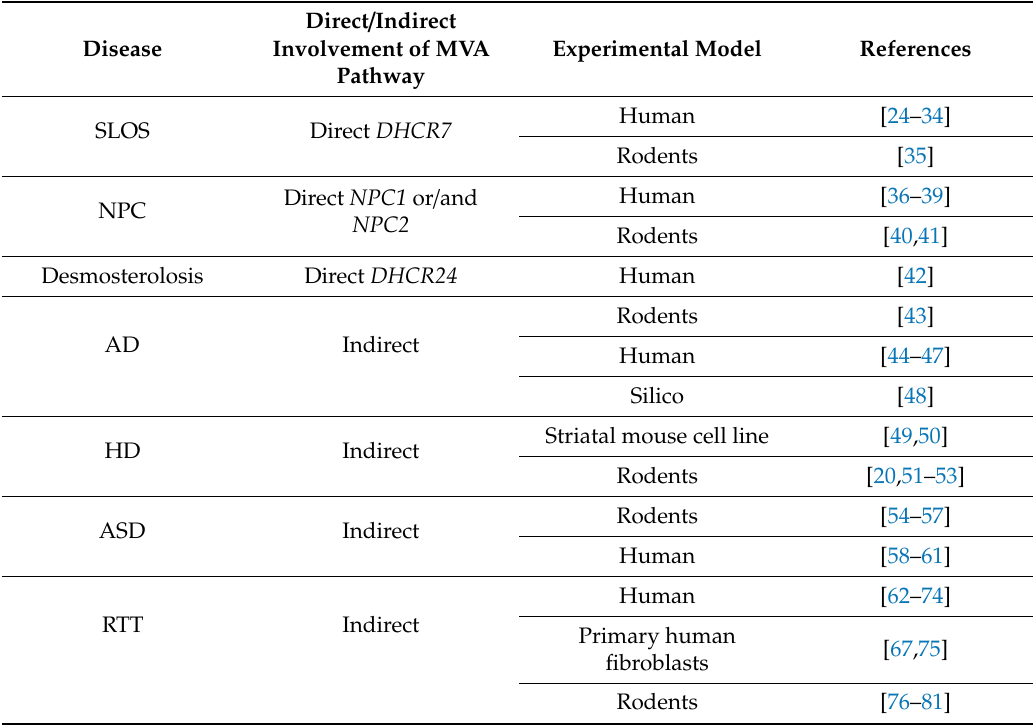
Table 1. Highlights of the direct and indirect involvement of MVA pathway in some brain diseases and the experimental models used. Smith–Lemli–Opitz syndrome (SLOS); NPC (Niemann-Pick type C); Alzheimer’s disease (AD); Huntington’s disease (HD); Autism spectrum disorder (ASD); Rett